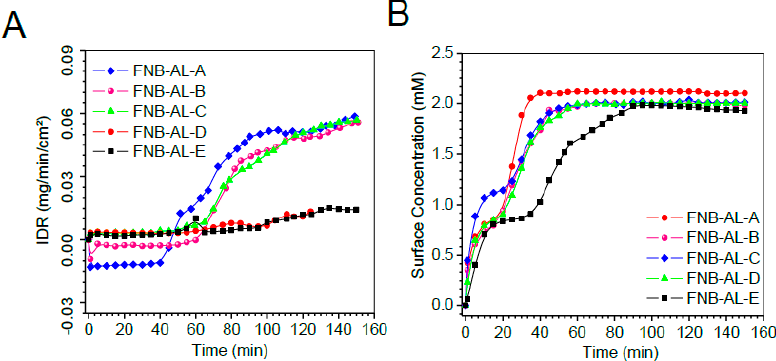
Figure 9. The surface concentration ( A ) intrinsic dissolution rates (IDRs), and ( B ) surface drug concentration of the drug from NCSMs as a function of time obtained by in situ real-time UV imaging at a flow rate of 100 µL/min. Error bars represent the standard deviation (n = 3) in the supplementary Figure S2.